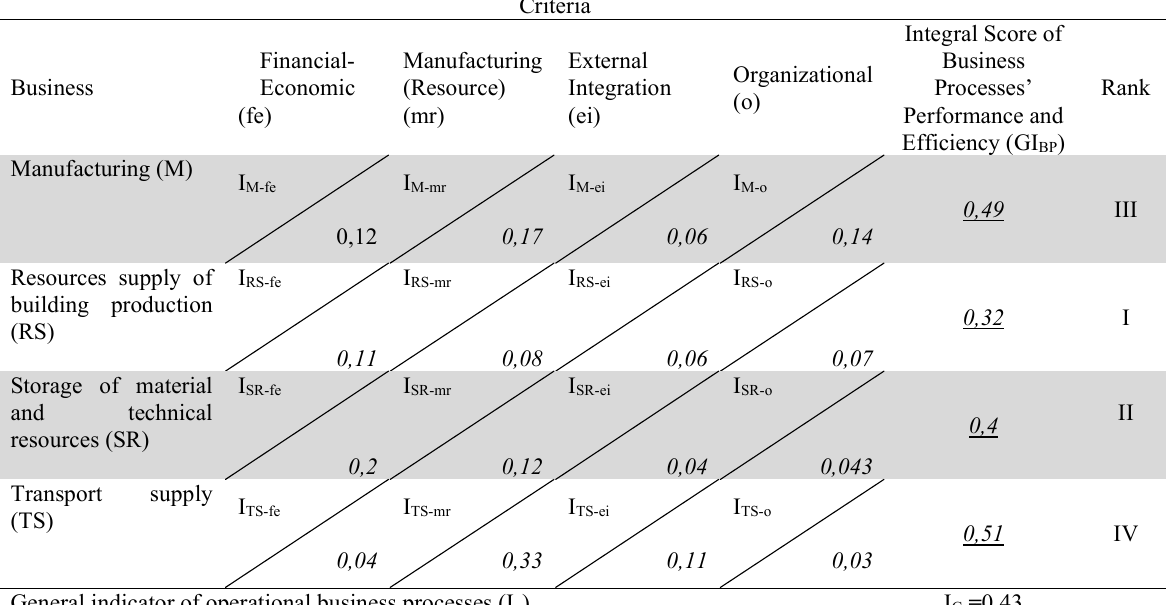
Estimated indicators matrix of operational business processes’ performance and efficiency of a building